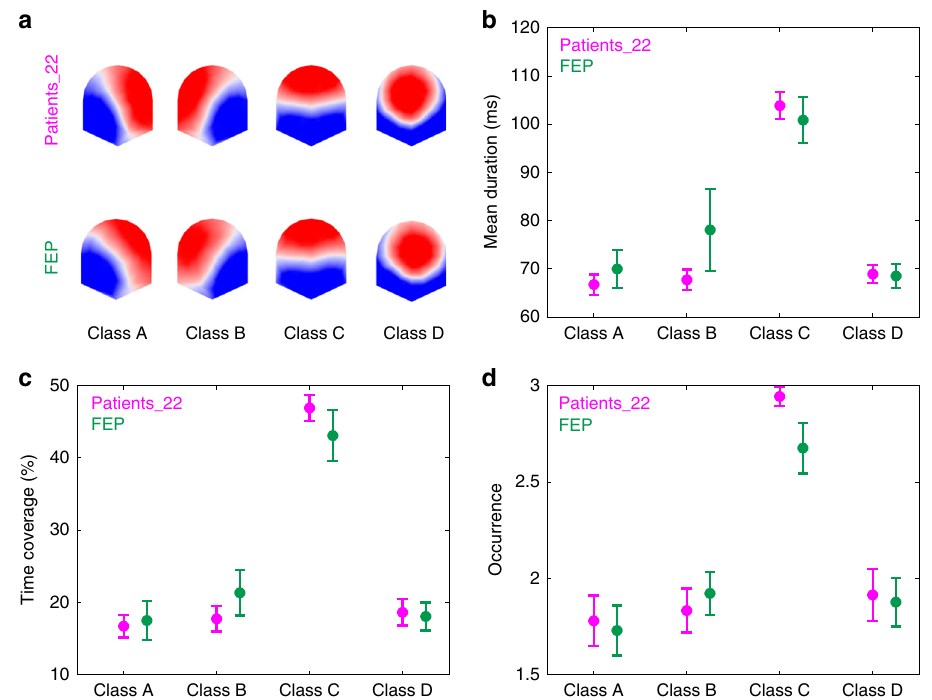
Fig. 2 Results of the microstate analysis for study 2. Patients with fi rst episode of psychosis (FEP, n = 22) data are displayed in green and their matched patients with schizophrenia (Patients_22, n = 22) data in magenta. a The spatial con fi guration of the four microstate classes (A, B, C, and D) for the two groups. Group average statistics of the temporal microstate parameters: b mean duration, c time coverage, and d occurrence. For each microstate parameter, we computed a two-way repeated measures ANOVA with Group (FEP and Patients_22) and Microstate Class (A, B, C, and D) as factors. No statistically signi fi cant group differences and no statistically signi fi cant Group × Microstate Class interaction effects were found for any of the microstates parameters. Error bars indicate s.e.m. Group average statistics are also shown in Supplementary Table 9. Source data are provided as a Source Data fi